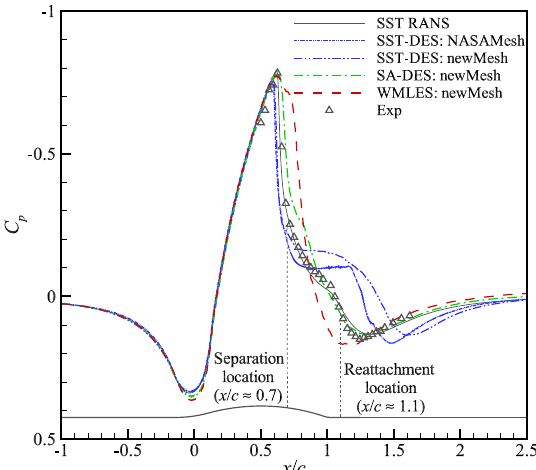
Figure 16. Mean pressure distribution along the wall-mounted axisymmetric bump obtained by DES and WMLES